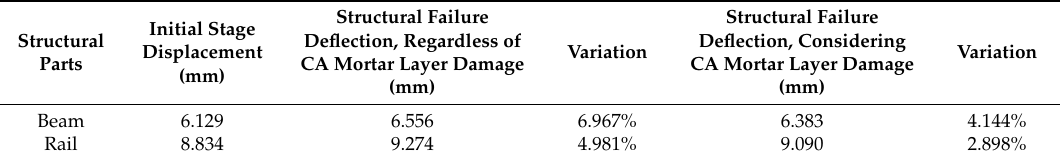
Table 8. Summary of beam and rail deflection variation.